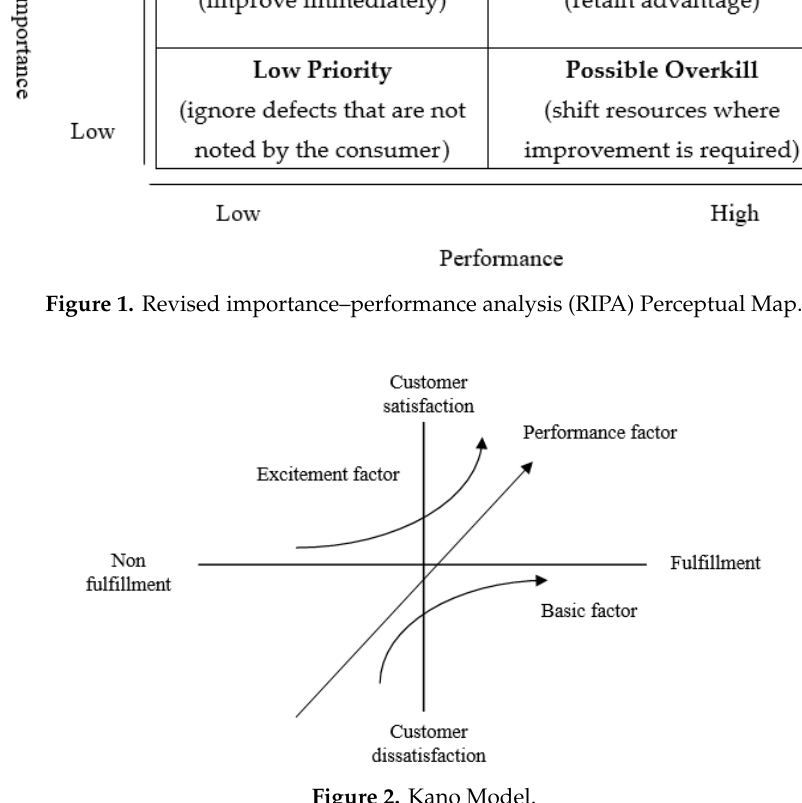
Figure 2. Kano Model.